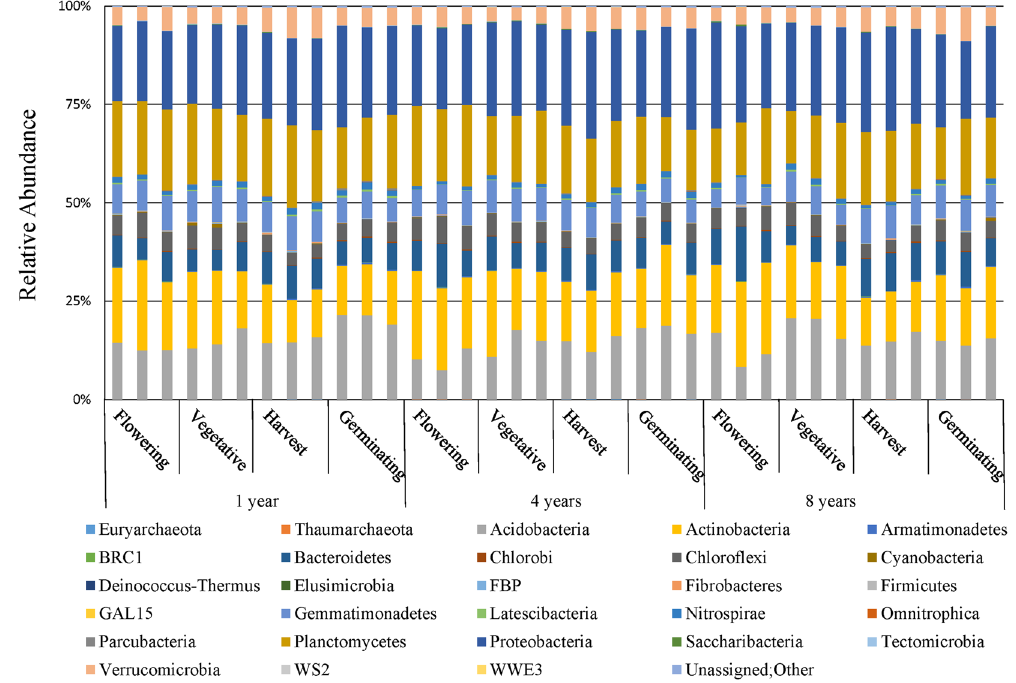
Figure 1. Relative abundance (%) of the major bacterial and archaea phyla present in the rhizosphere prokaryotic community at each developmental stage of Potentilla anserina